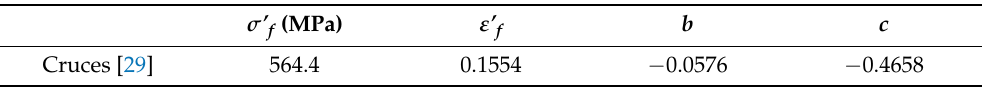
Table 1. Material constants in SWT damage parameter of S355.